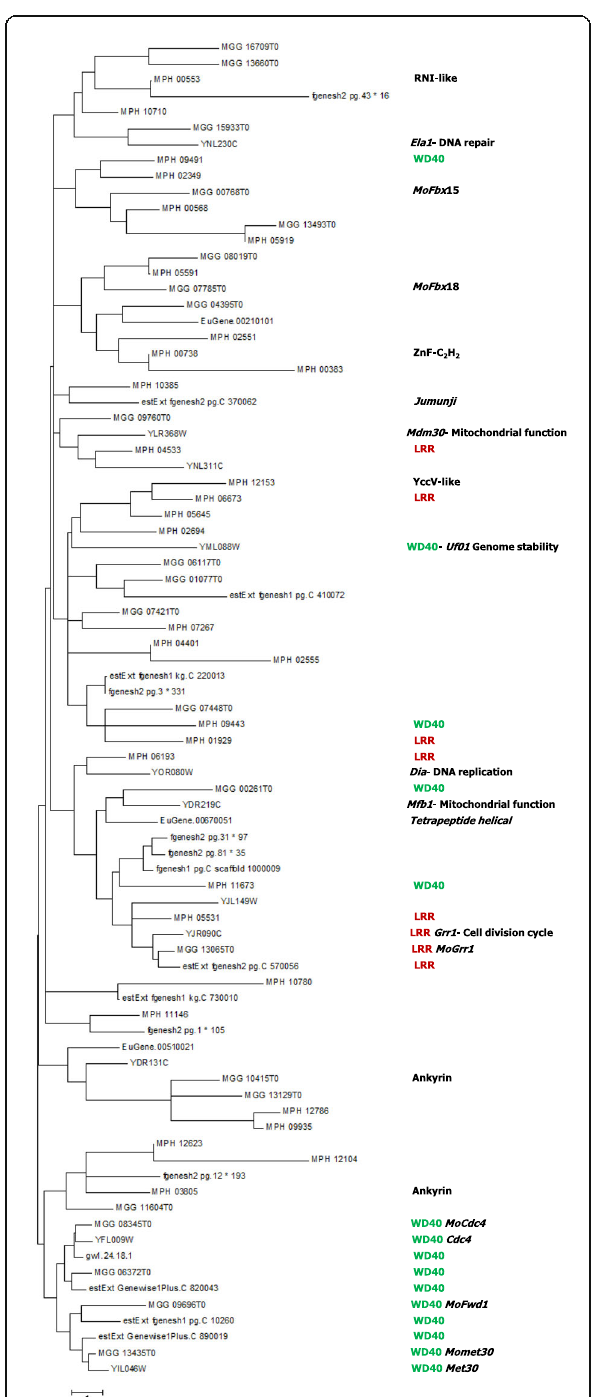
Fig. 5 Phylogenetic analysis of F-box proteins of Macrophomina phaseolina. Phylogenetic analysis was carried out by MEGA 6.0